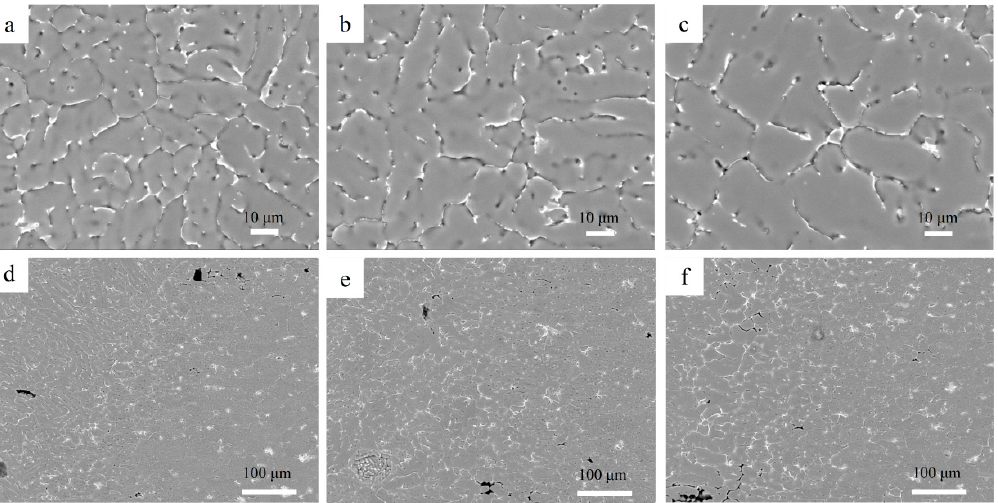
Figure 7. Different welding heat input under the center of the weld and fusion line scan: ( a ) 90 A; ( b ) 105 A; ( c ) 120 A; ( d ) 90 A; ( e ) 105 A; ( f ) 120 A.